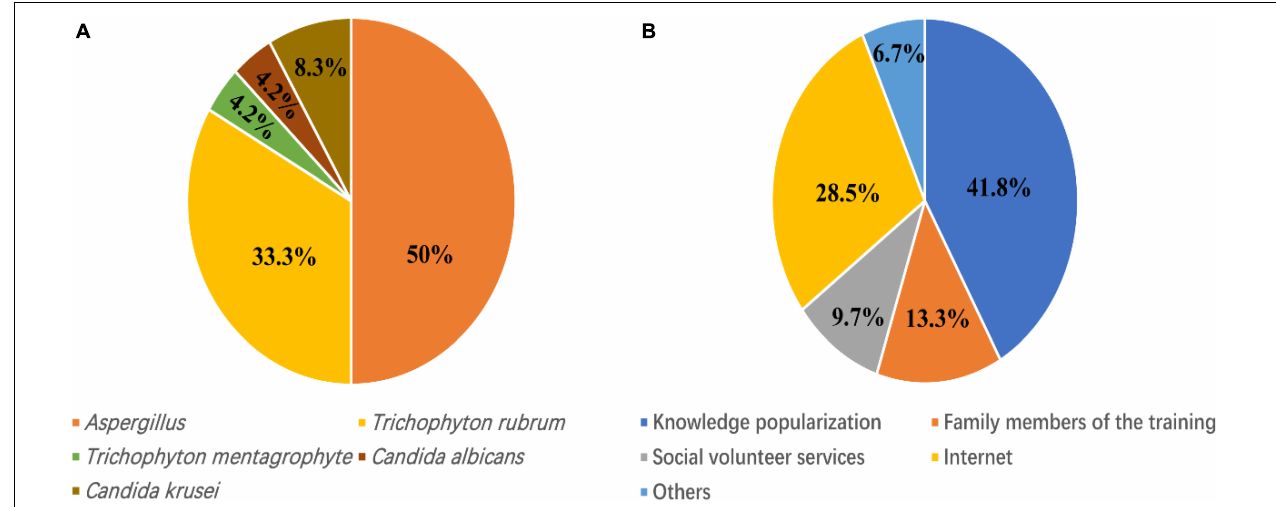
FIGURE 3 | Fungal species identification outcomes and the ways to skin rehabilitation guidance . (A) Fungal species identification findings from 24 amputees of fungal skin infection. (B) The methods of prosthesis nursing and skin rehabilitation